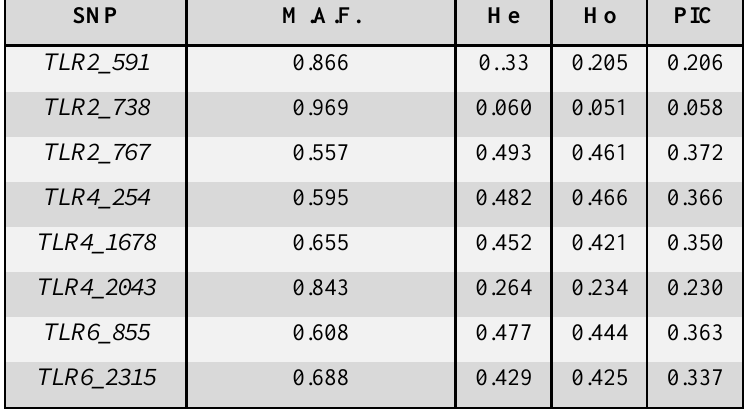
Table 3. Frequencies of the major allele (M.A.F.), expected heterozygosity (He), observed heterozygosity (Ho), Polymorphism Information Content (PIC) of the 8 characterized SNPs.